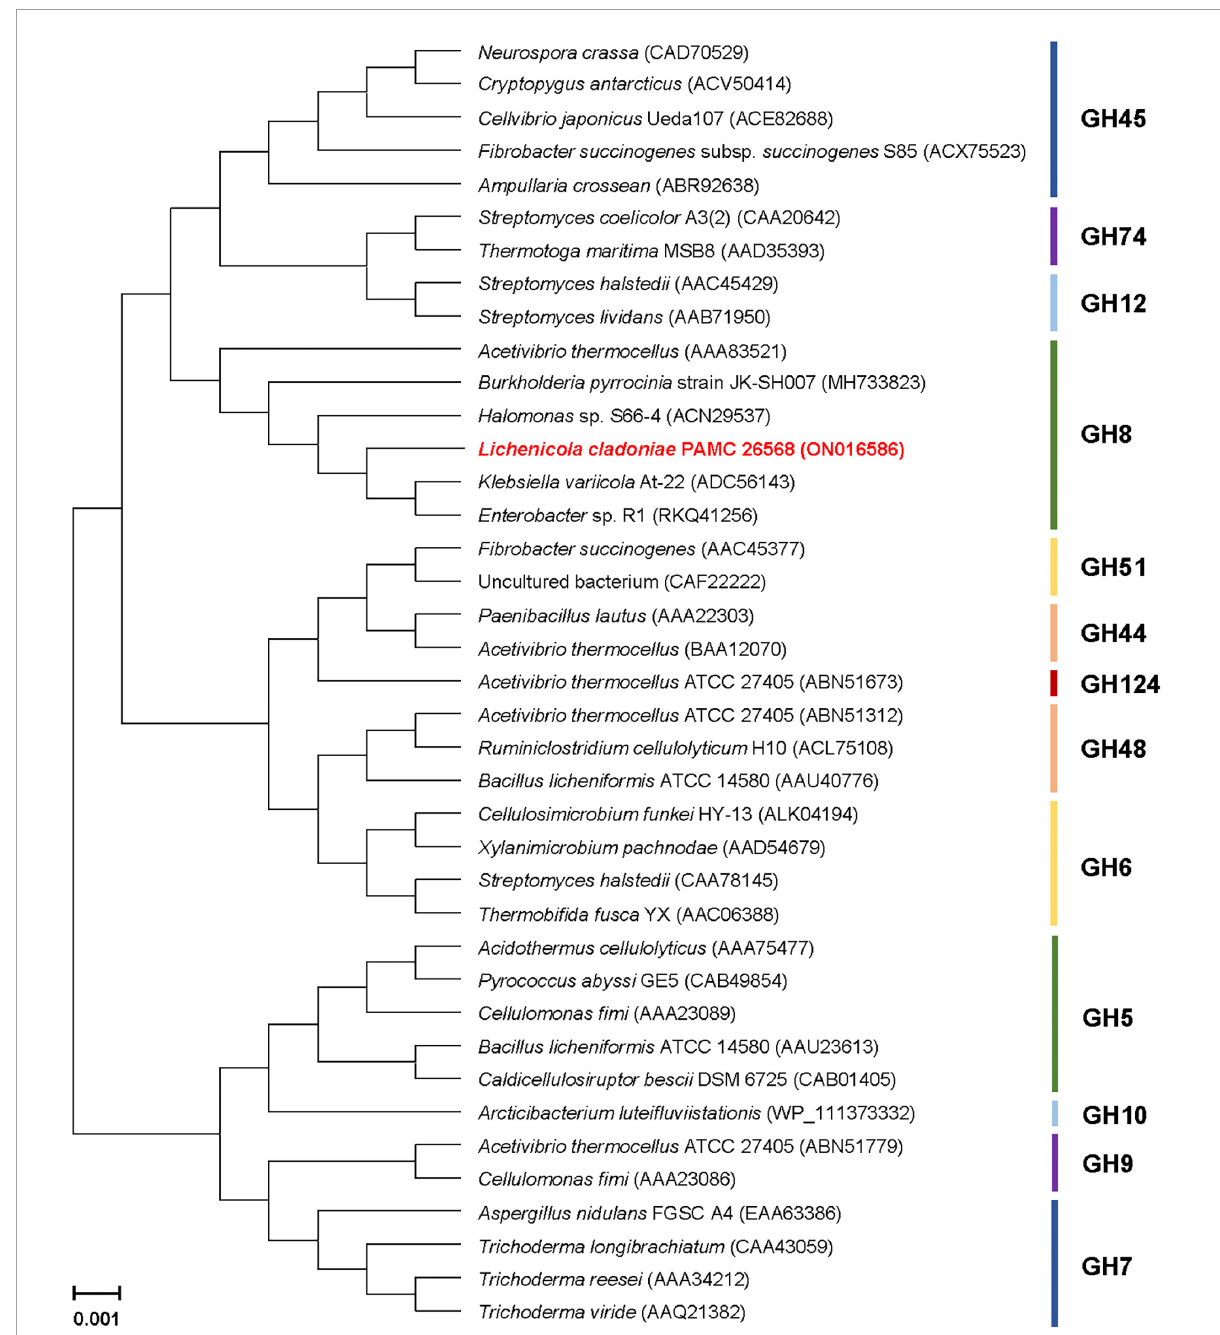
FIGURE2 Phylogenetic analysis of Lichenicola cladoniae PAMC 26568 GH8 endo- β -1,4-glucanase (GluL) and its closely related functional homologs. Alignment of the amino acid sequences was achieved using ClustalW in the MegAlign program (DNASTAR Inc., Madison, WI, United States). The protein sequence data employed for phylogenetic analysis were retrieved from the GenBank database.